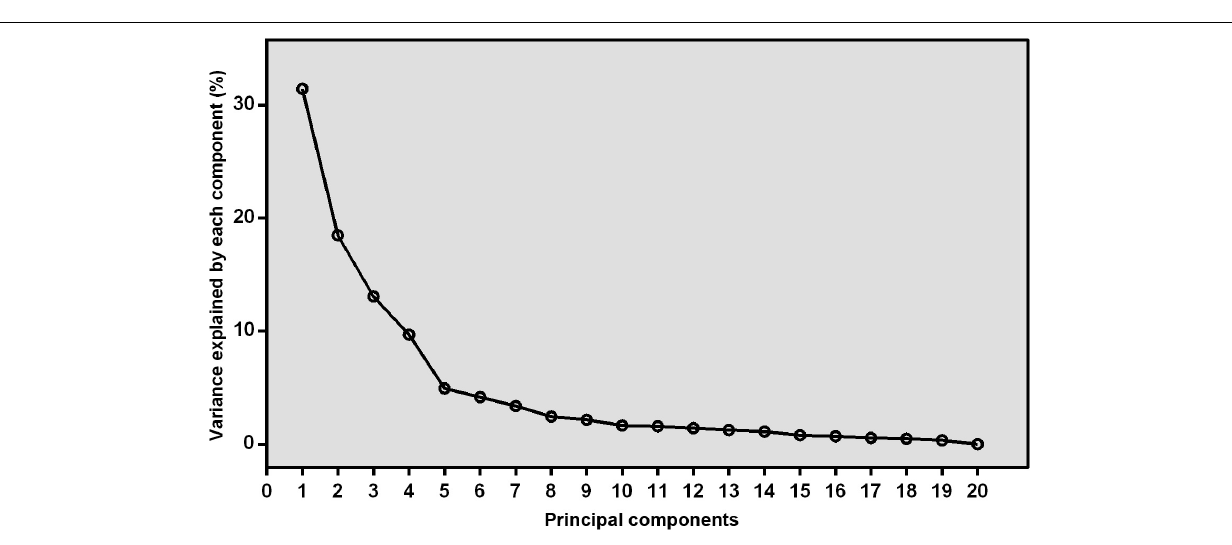
FIGURE 2 | The scree plot derived from principal component analysis. The variance that explained by each component (%) was